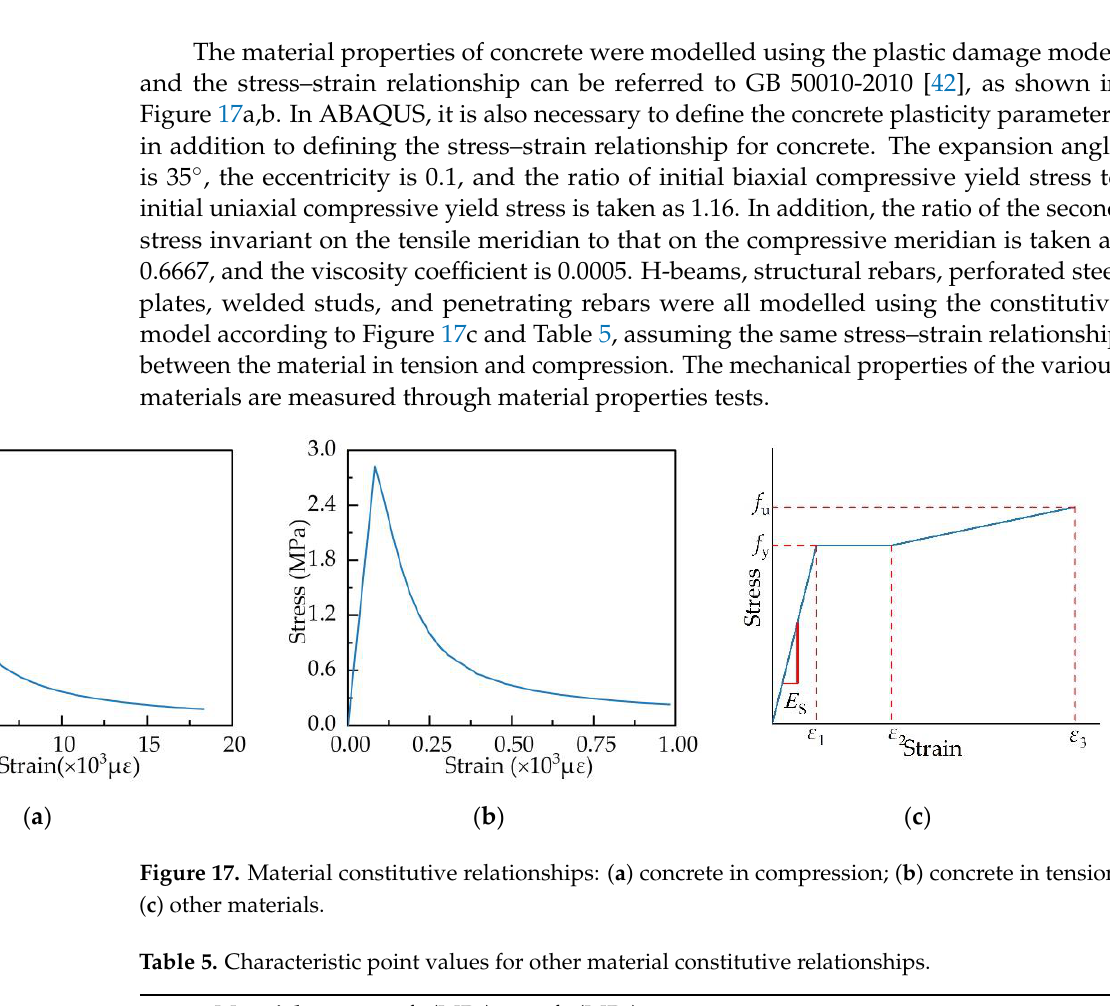
Figure 16. Boundary conditions of the model.